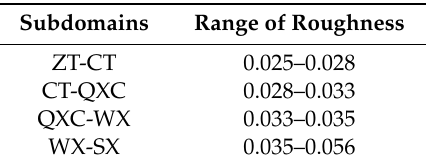
Table 1. Roughness of